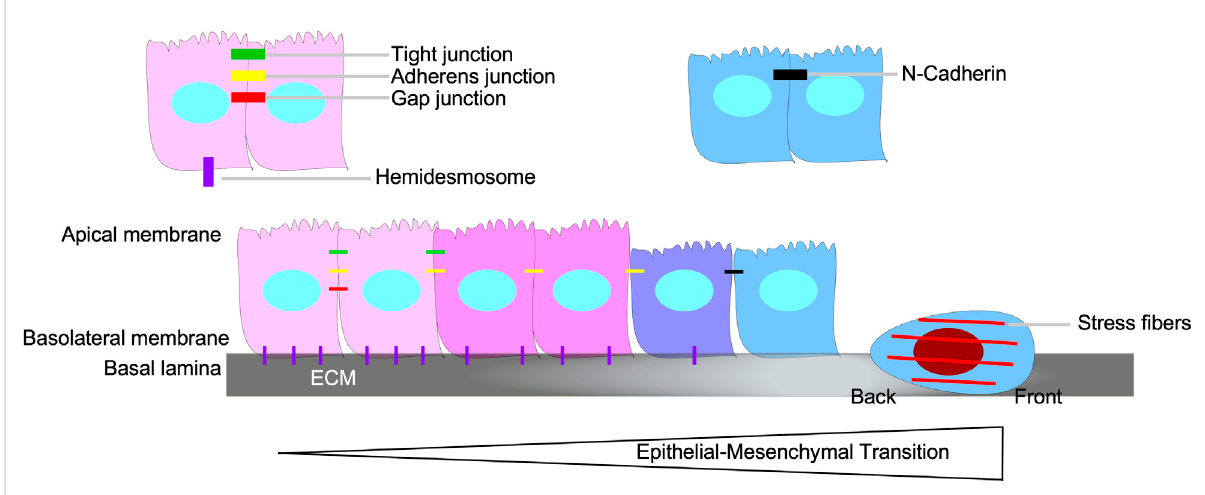
FIGURE 8 Epithelial-mesenchymal transition. Epithelial-mesenchymal transition (EMT) is the biological process of an epithelial cell loses its epithelial properties, such as apical/basolateral polarity, tight junctions, gap junctions, adherens junctions, and hemidesmosomes, and develop mesenchymal properties, which includes the capacity to breakdown the basal lamina, assert back/front polarity, spindle-shaped morphology, induce stress fi ber formation, and N-Cadherin-dependent cell-cell